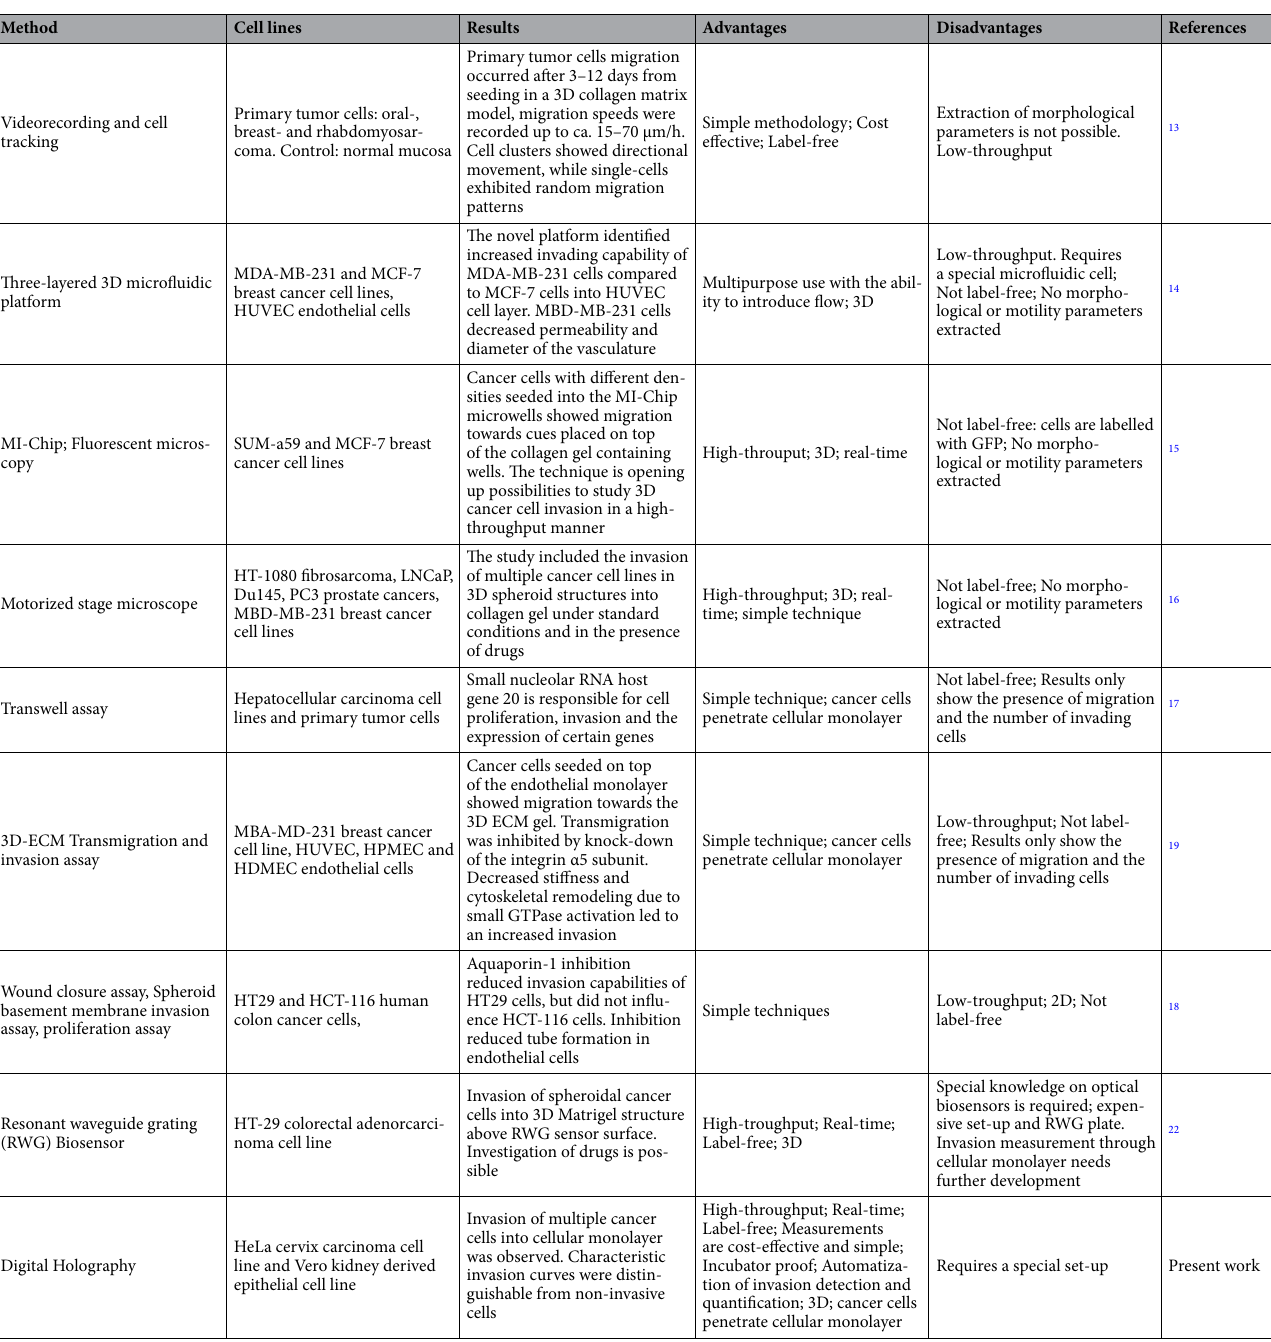
Table 1. Collection of previously published methods and results from cancer cell invasion studies. HM enables a real-time and label-free approach, which is optimal for the detection of invasion of cancerous HeLa cells into a confluent Vero monolayer grown on